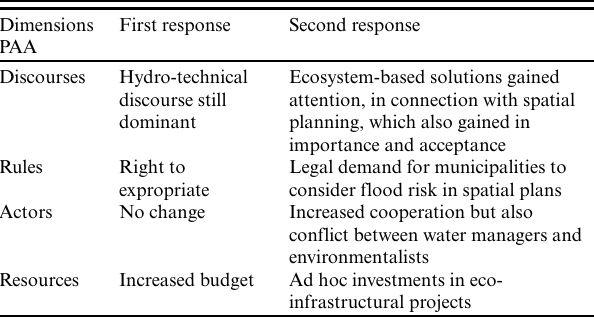
Table 11 . Institutional consequences after the flood of 2010. PAA = policy arrangement approach.